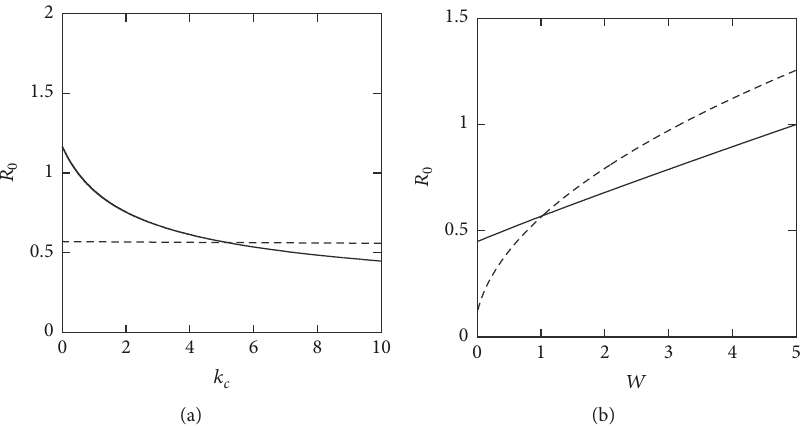
Figure 2: Dependence of 𝑅 0 on 𝑘 𝑐 and 𝑊 in the stationary state. (a) Dependence of 𝑅 0 on 𝑘 𝑐 . 𝑊 = 1.0 . The solid and dashed curves represent the cases of 𝛼 = 0 and 5, respectively. (b) Dependence of 𝑅 0 on 𝑊 . 𝑘 𝑐 = 5.0 . The solid and dashed curves represent the cases of 𝛼 = 0.1 and 5.0,